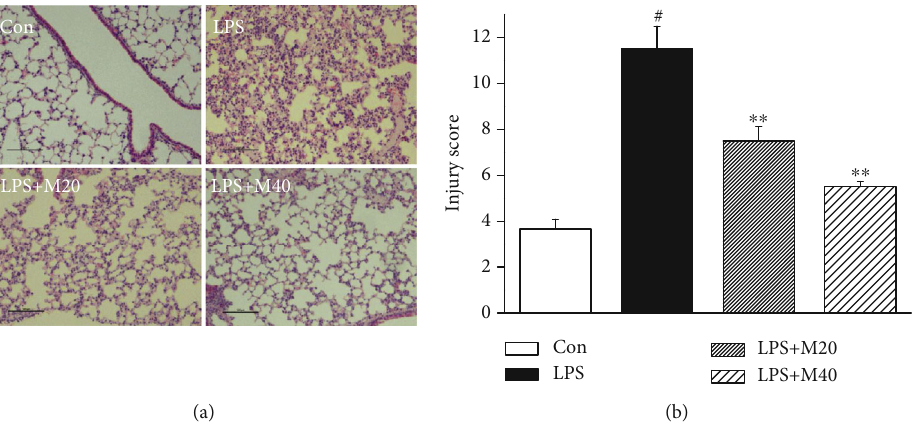
Figure 3: Mibefradil attenuated histological changes in lung tissues of LPS-induced ALI mice. Mibefradil (20 and 40 mg/kg) was treated 0.5h before LPS challenge. Mice were sacri fi ced 6 h after LPS exposure. The left lung was fi xed, embedded in para ffi n, and cut into 5 μ m slices. Histological assay was conducted by light microscopy after H&E staining (a), and lung injury was scored (b). All values are mean ± SEM ( n = 6 ). # p < 0 : 05 , signi fi cant compared with vehicle-treated control; ∗ p < 0 : 05 , signi fi cant compared with LPS alone; ∗∗ p < 0 : 01 , signi fi cant compared with LPS alone.